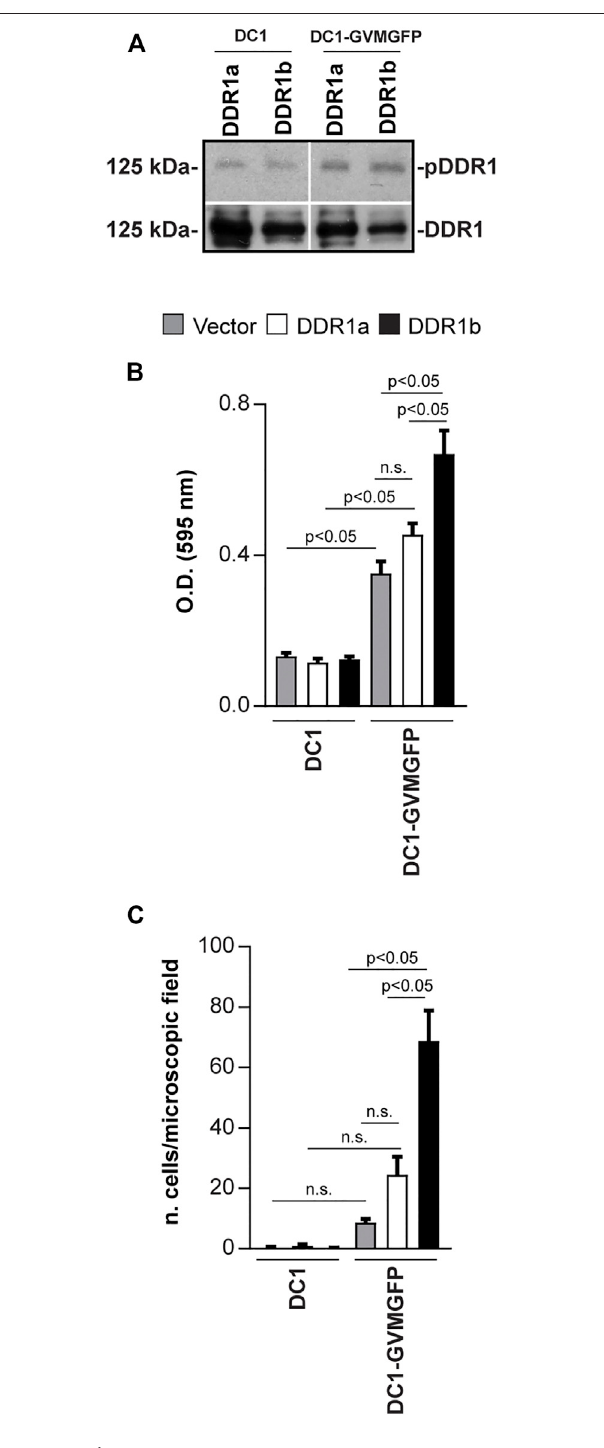
FIGURE 2 | DDR1b supports cell adhesion and migration on DDR- selective substrata. (A) Serum-starved HEK-DDR1a or HEK-DDR1b were treated with DC1 or DC1-GVMGFP (100 µg/ml) for 90 min and the levels of phosphorylated and total DDR1 were analyzed by Western blot. (B)